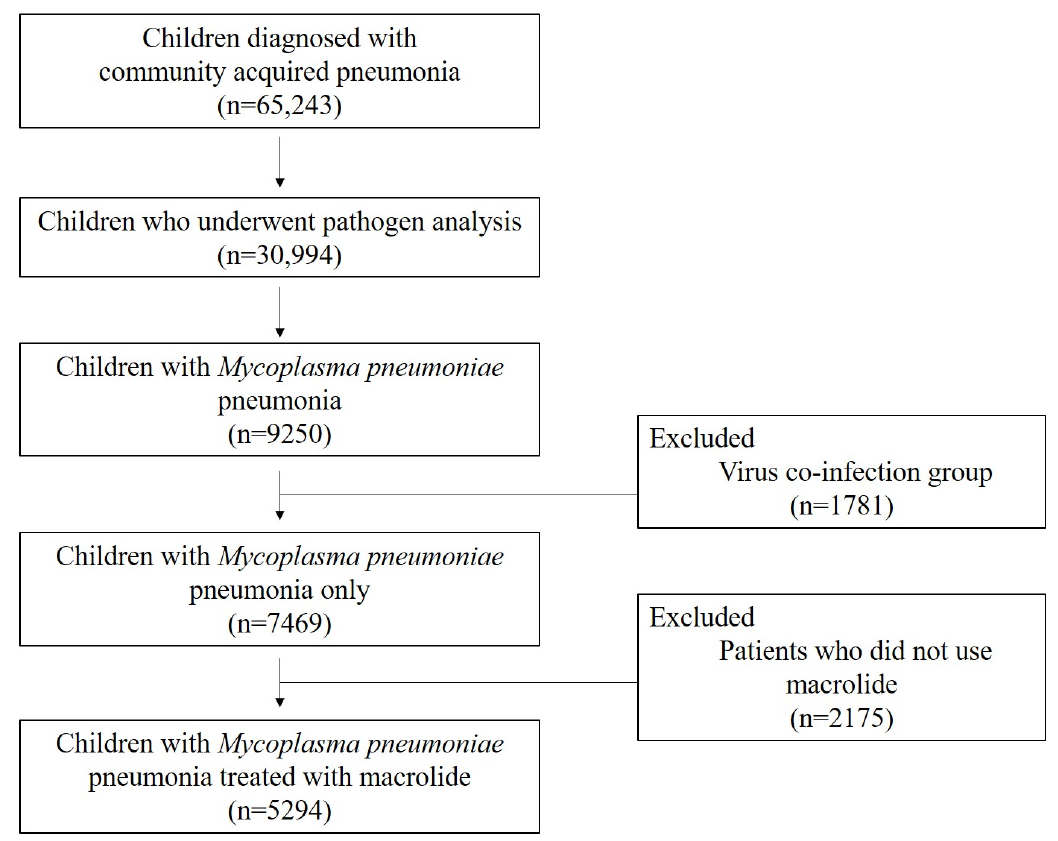
Figure 1. Inclusion